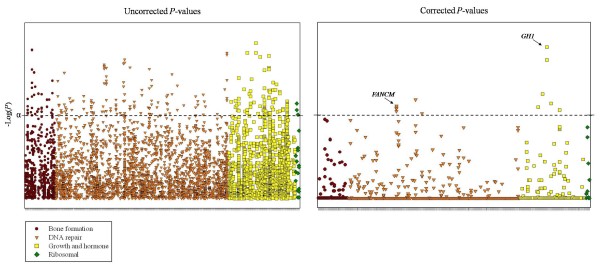
Plot of P values for each SNP by functional pathway before and after Bonferroni correction for the number of SNPs per gene. Inset shows the pathway designations. 4836 SNPs in 255 candidate genes are shown. α = 0.05; dashed line represents an extension of α.